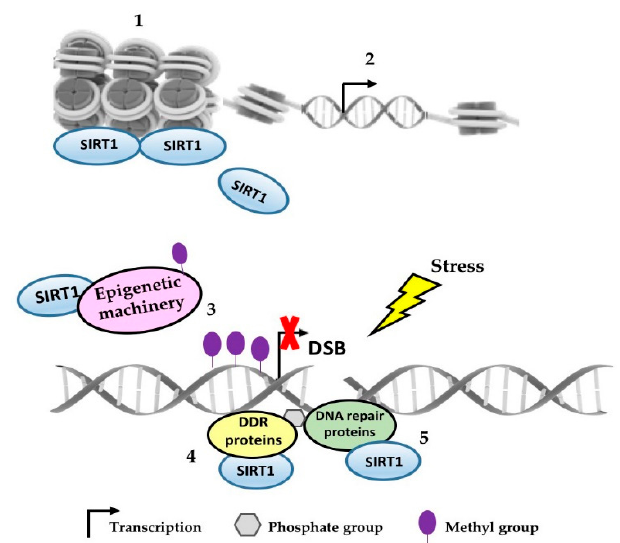
Figure 1. SIRT1 as an epigenetic regulator and DNA repair response modulator. SIRT1 contributes to heterochromatin formation and can be associated with transcriptionally repressed repetitive DNA loci ( 1 ); upon stress, SIRT1 can be dissociated from these regions towards the DNA damage site, resulting in chromatin reorganization which favors transcriptional changes ( 2 ); SIRT1 recruits epigenetic machinery to the transcriptional silencing around the DNA damage site ( 3 ); SIRT1 also participates in the recruitment and deacetylation of DDR ( 4 ) and DNA repair proteins, ( 5 ) helping in many steps of repair pathways.